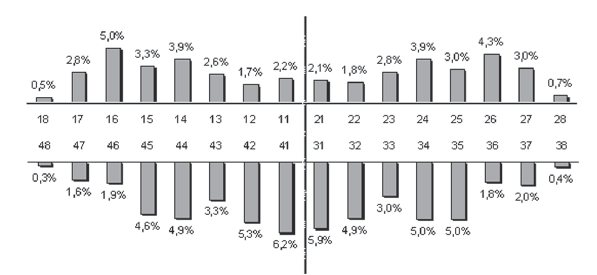
FIGURE 2 - Severity of gingival recession according to age